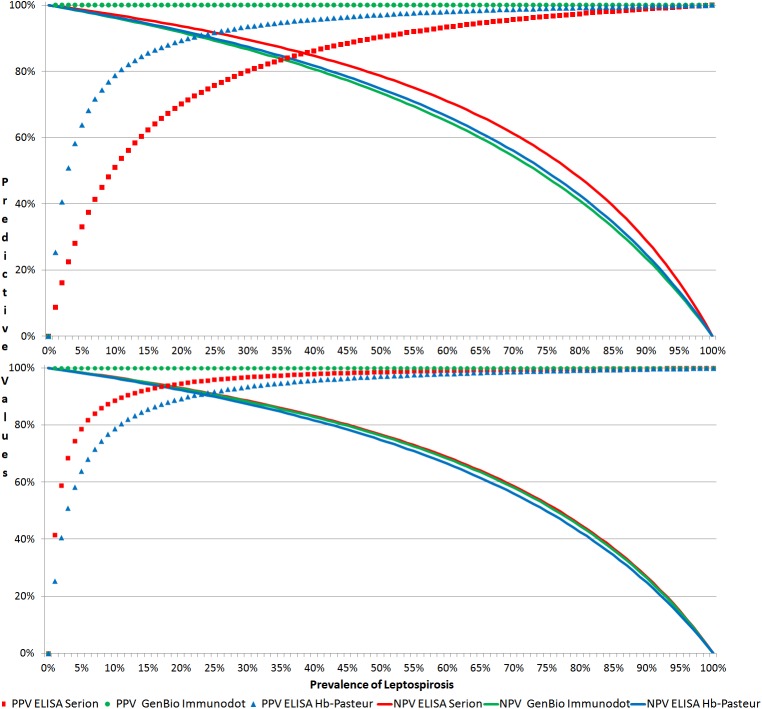
Predictive values according to estimated prevalence before (top) and after (bottom) threshold optimization.